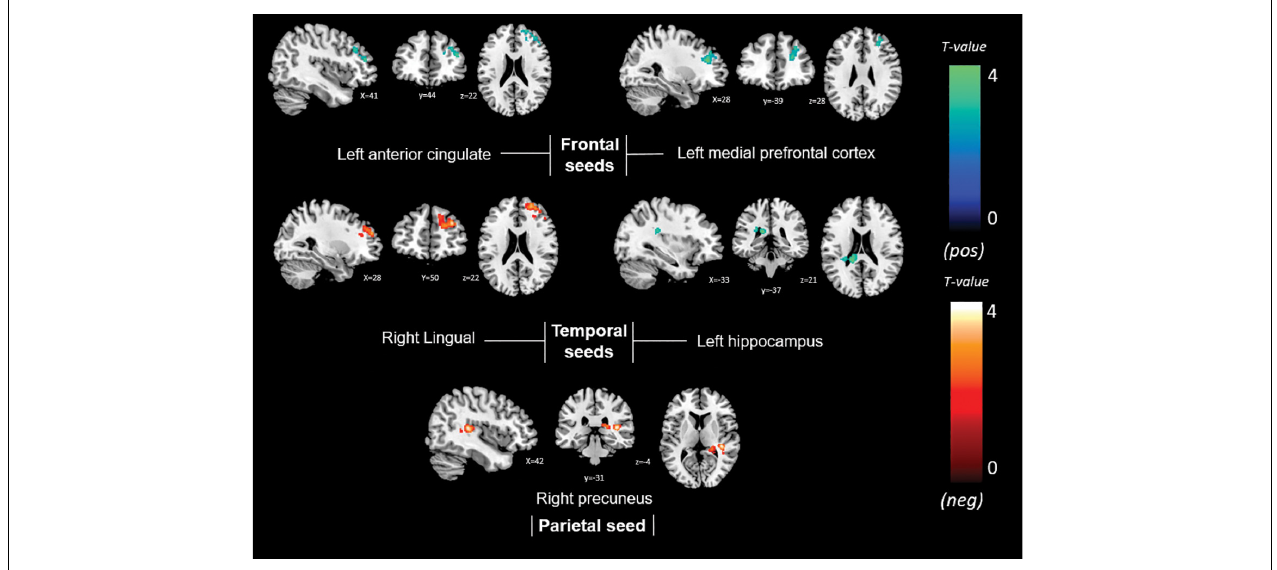
FIGURE 5 | Positive (blue) and negative (red) correlations between brain functional connectivity of selected unilateral seed regions and non-memory anosognosia scores.